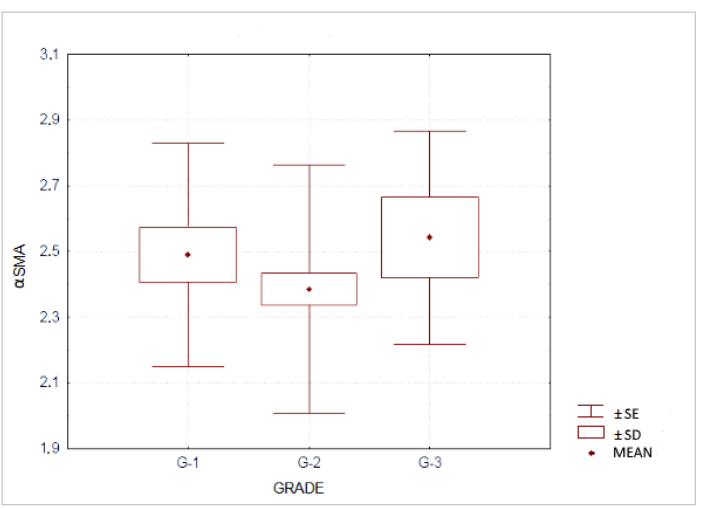
Figure 5. Expression of α SMA in pancreatic ductal adenocarcinoma according to the degree of histological differentiation.